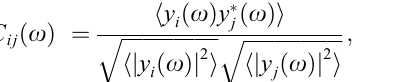
Fig. 3. Excerpt showing F30, F10.7, MgII and SEM. The latter three are rescaled to F30 by using a quadratically nonlinear model in order to reveal their